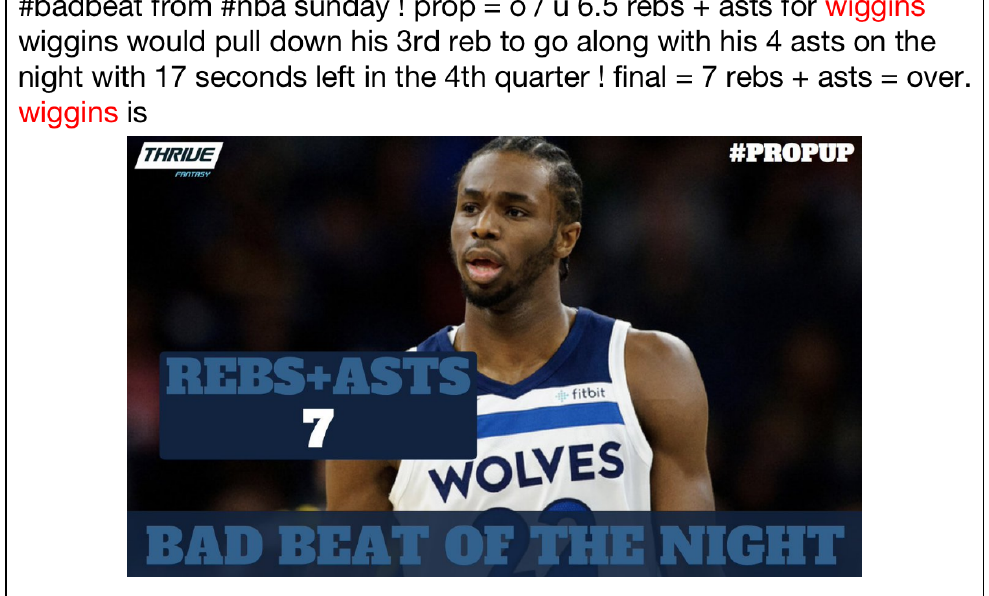
Figure 5. An example of a result error where wiggins should be linked to a basketball player rather than an NFL